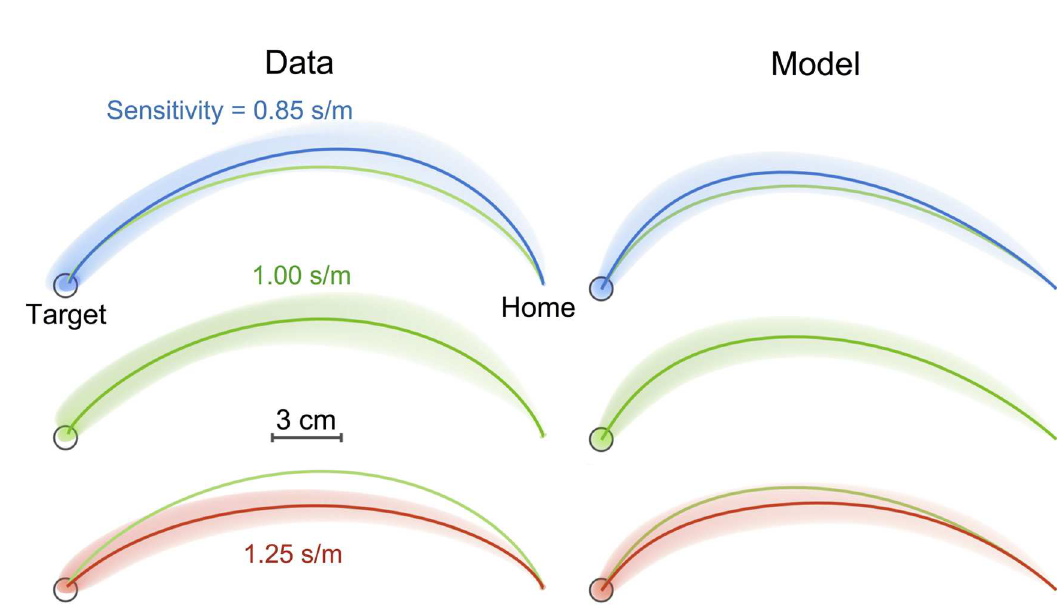
Fig 8. Hand paths in Experiment 2. Hand paths averaged over the final 50 movements of each sensitivity phase (subject mean ± s.d.). Left and right columns show the observedand simulatedpaths. For comparisonpurposes, the averagepaths for the intermediate sensitivity (green)is repeatedon the high and low sensitivity